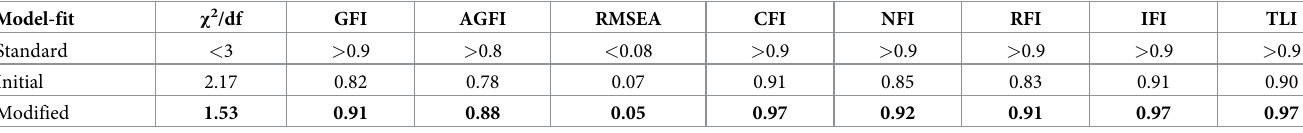
Table 5. Model-fit criteria and the test